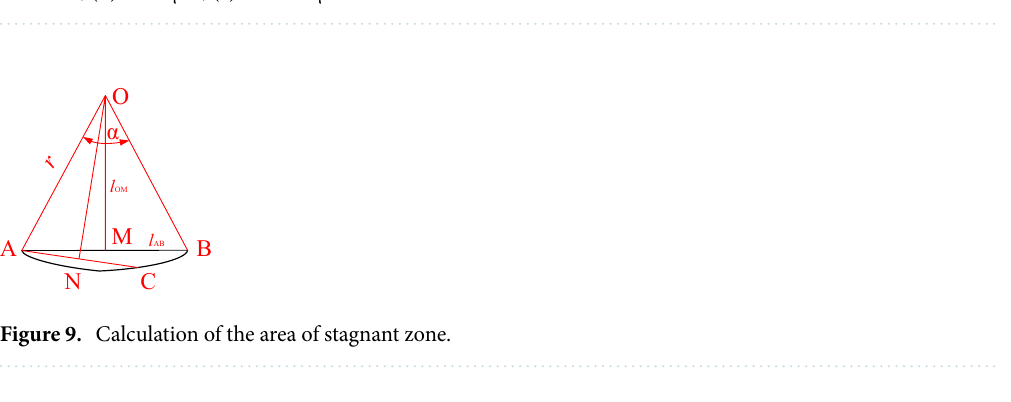
Figure 8. Material flow and stagnant zone of rivet shaft under different vibration conditions: ( a ) without vibration, ( b ) A = 3 μm, ( c ) A = 5.77 μm.